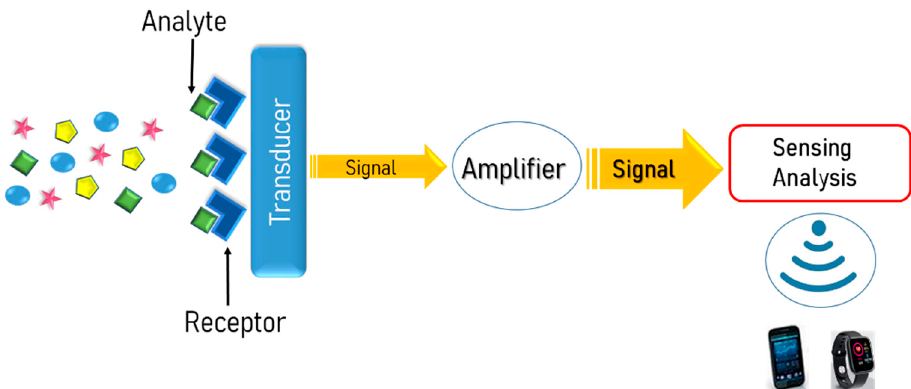
Figure 1. Schematic illustration of the basic functional units of a typical chemosensor.